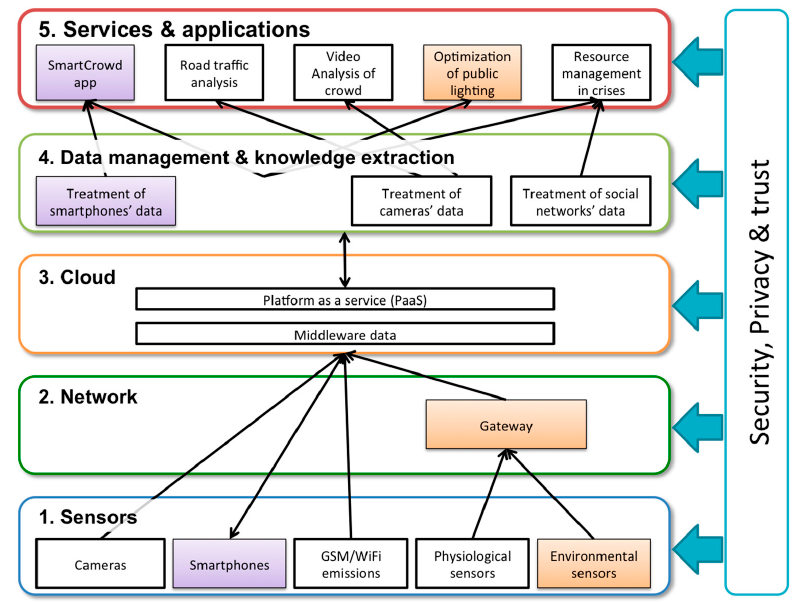
Figure 3. The iNUIT architecture with the modules developed within the SmartCrowd and OpEC (Optmisation de l’Eclairage public) projects tinted in purple and orange, respectively. The modules in white have been developed during other projects within the iNUIT